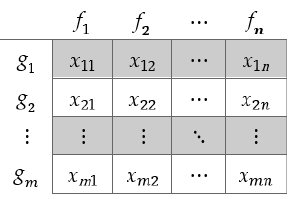
Figure 3. The relationship between the elements ( f i ), subgroups ( g j ), and decision variables ( x ji ). Problem constraints are categorized into two main categories: